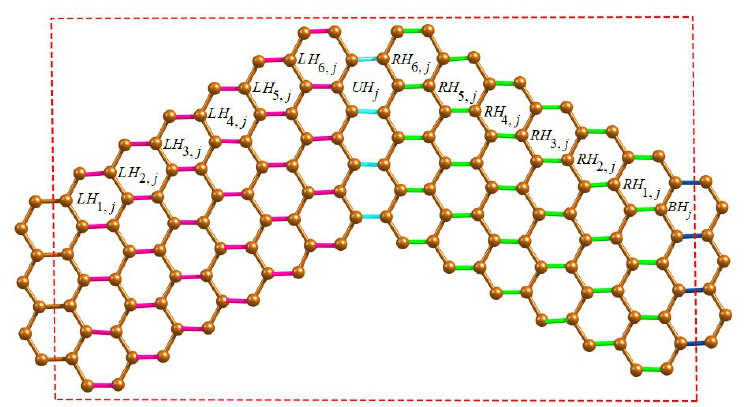
Figure 2. H-type Θ -classes for the j th unit of WNR ( 4,6, n )